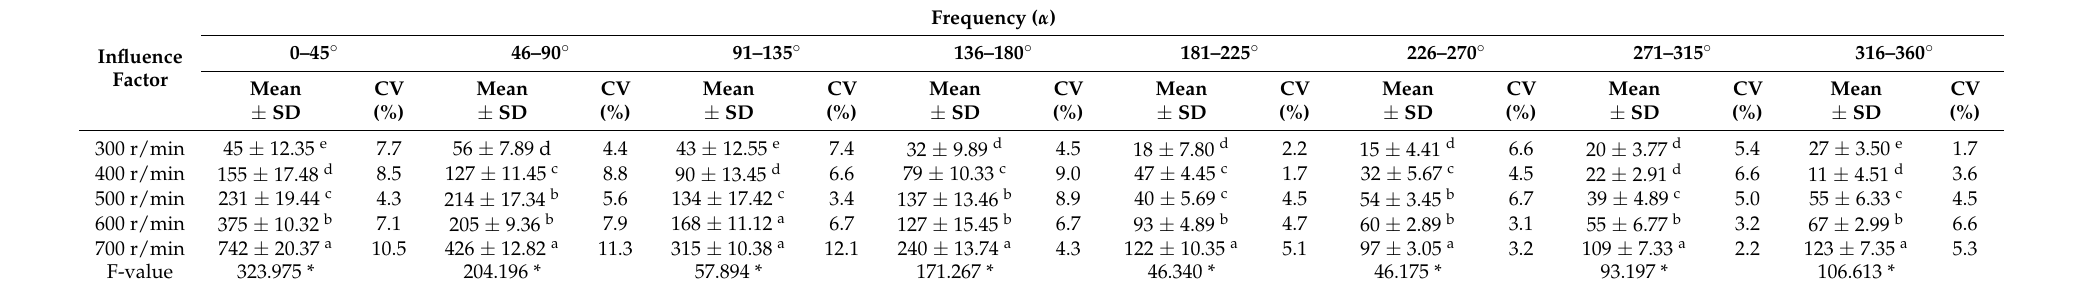
Table 4. Effect of process parameters on Frequency ( α ) of corn cobs and repeated measures analysis of